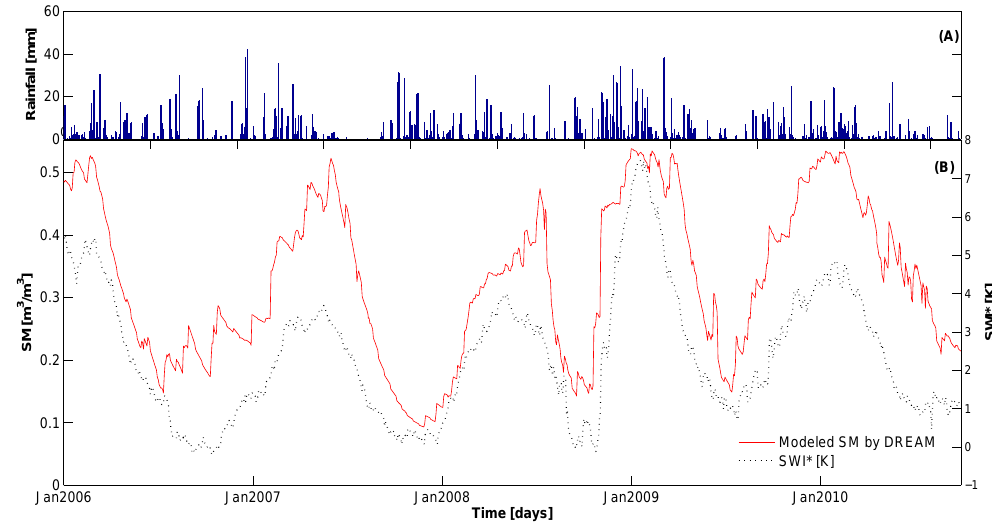
Fig. 7. (A) Time series of daily rainfall. (B) Comparison between the SM (m 3 m − 3 ) simulated by DREAM model and the SWI ∗ (K) index as a function of time expressed in days. On y-axes one finds the SM on the left and SWI ∗ on the right side.